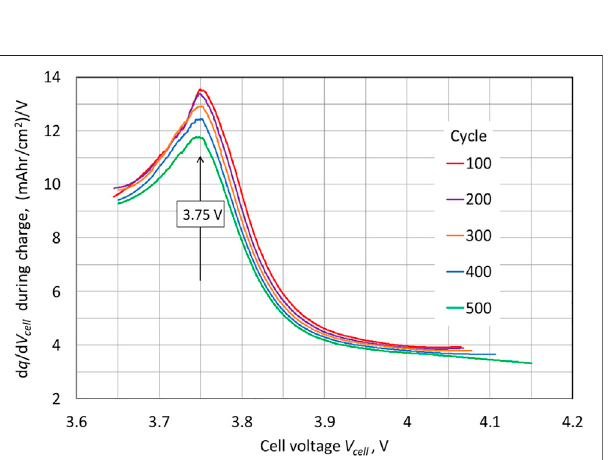
FIGURE 2 | Cell voltage vs. time for various cycles. The current density schedule is the same for each cycle. A horizontal line is shown for V cell (cid:2) 3.75 V, corresponding to the dq / dV cell peaks shown in Figure 3 .